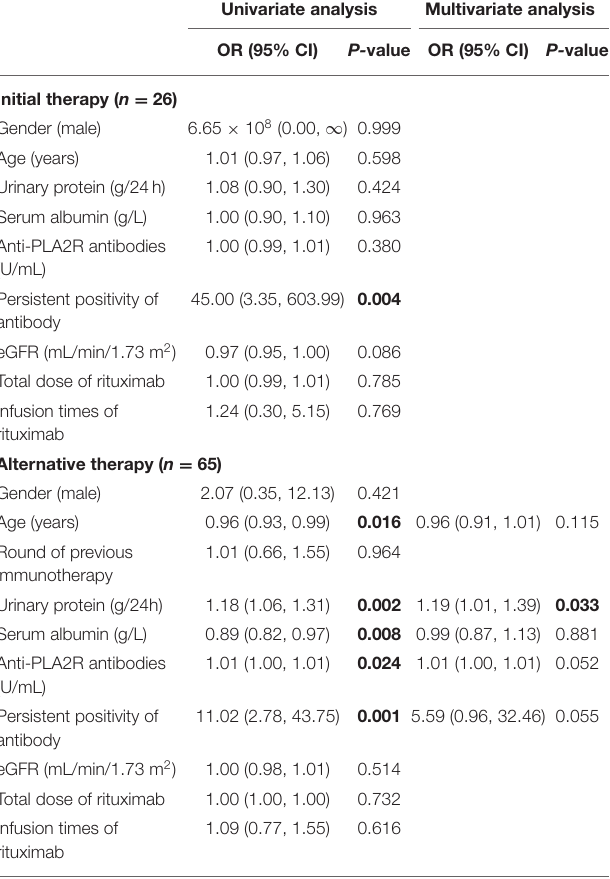
TABLE 3 | The risk factors for no-remission of patients with pMN receiving rituximab for initial therapy or alternative therapy (logistic regression). Univariate analysis Multivariate